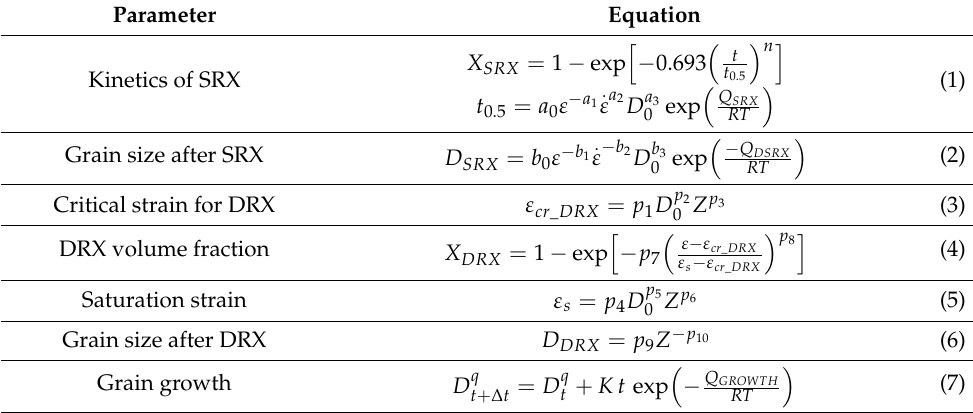
Table 1. Equations describing microstructure evolution during hot forming.